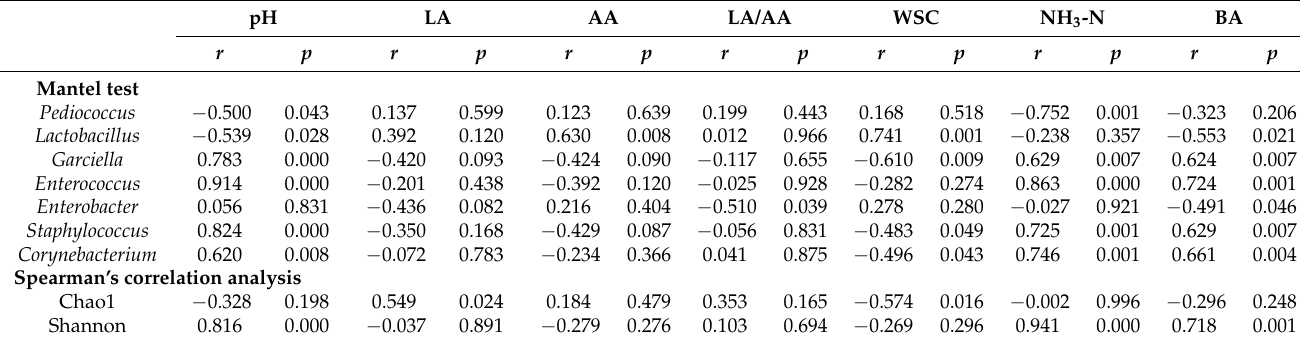
Table 5. Mantel test and Spearman’s correlation analysis for fermentation characteristics of alfalfa silage and relative abundance of bacteria at the genus